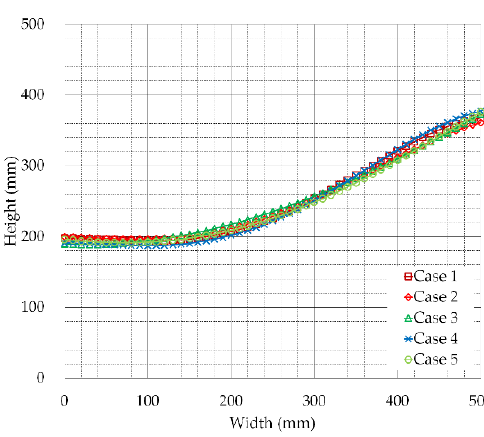
Figure 8. Comparison of fluid surface shape by earthquakes of different shapes.